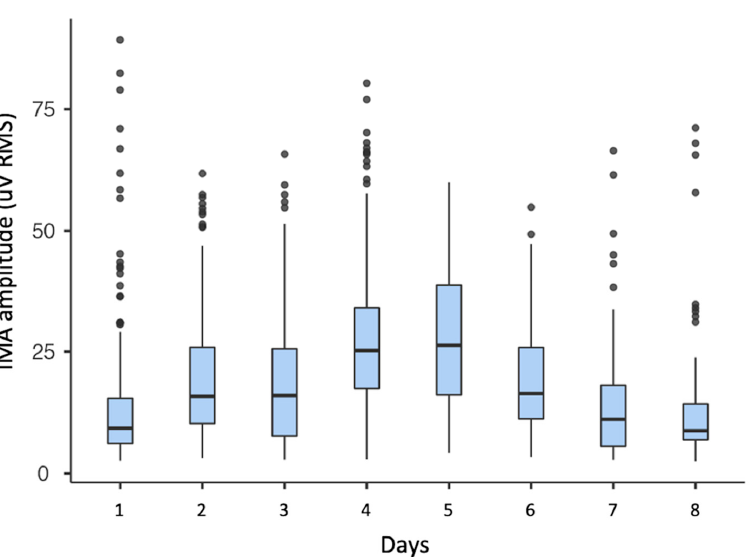
Figure 5. Boxplot of IMA RMS amplitude of one subject over the course of eight days of consecutive weeks of measurements.